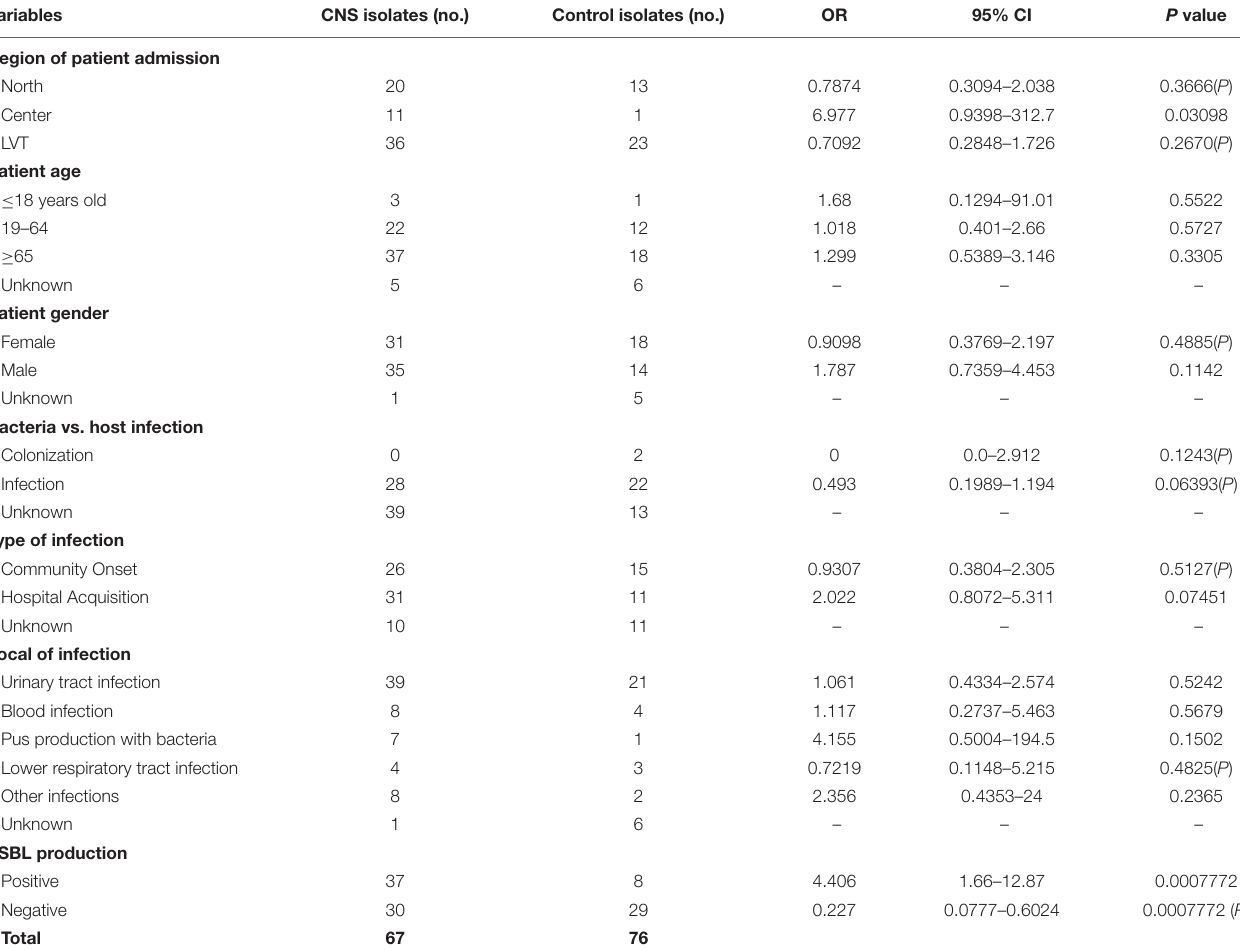
TABLE 2 | Evaluation of risk factors for patients with infections caused by carbapenem susceptible or CNSE bacteria. Variables CNS isolates (no.) Control isolates (no.)